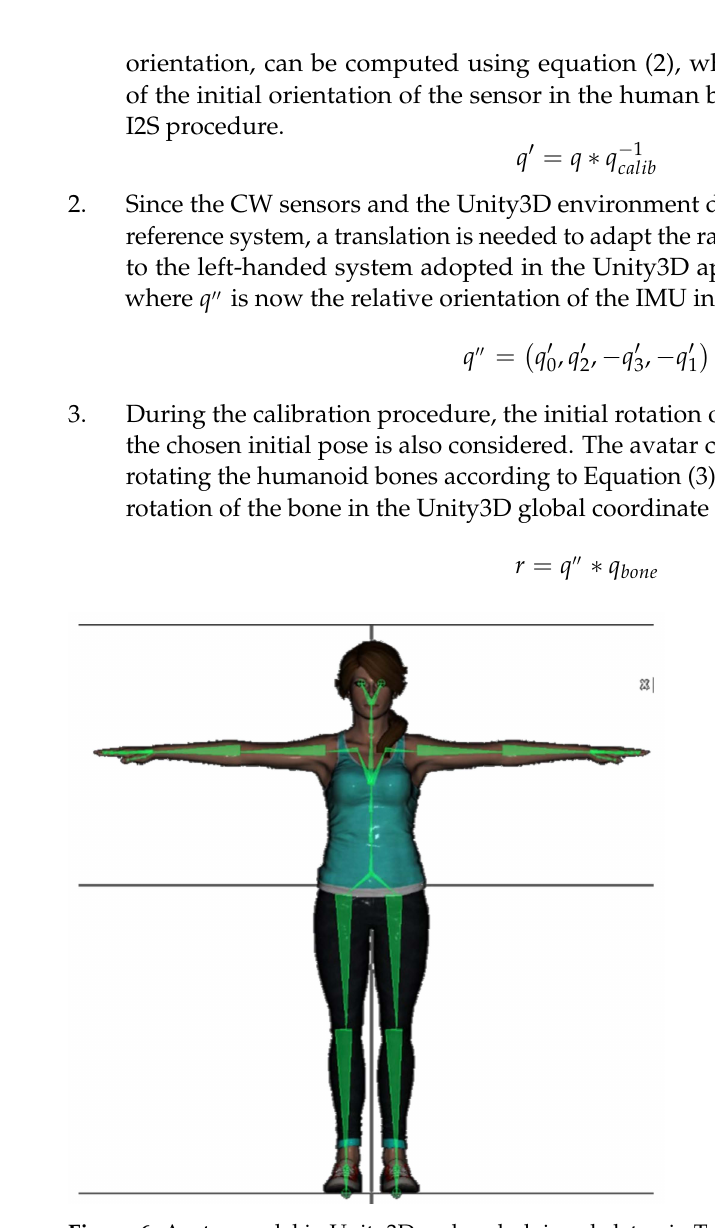
Figure 6. Avatar model in Unity3D and underlying skeleton in